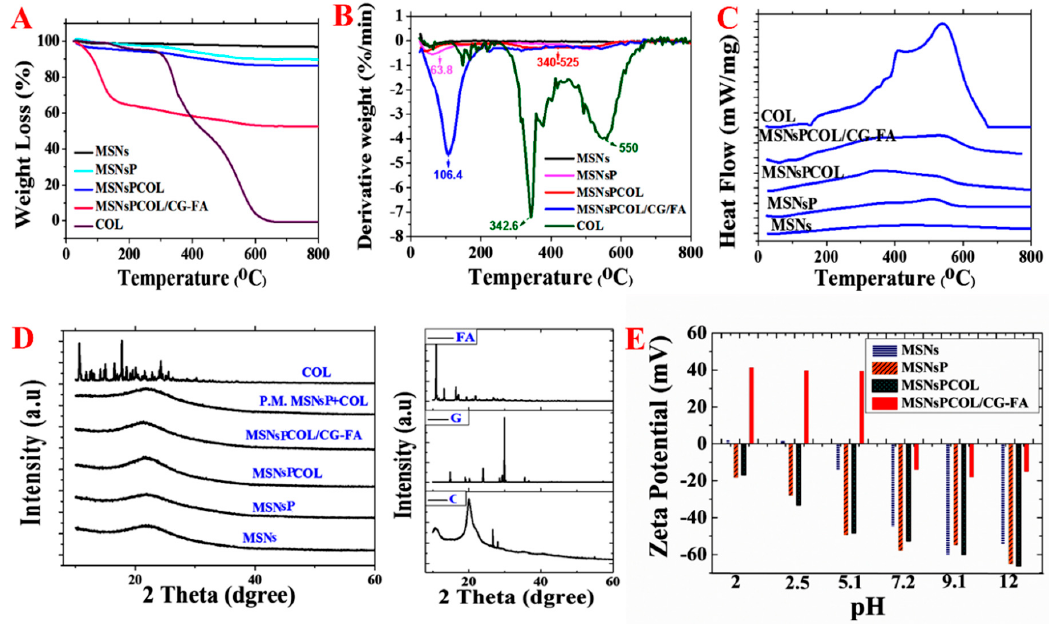
Figure 4. Thermal analysis of materials. ( A ) Simultaneous thermal analysis (STA) before and after surface modification, COL loading, and coating. ( B ) DTG analysis before and after surface modification, COL loading, and coating. ( C ) Differential scanning calorimetry (DSC) analysis before and after surface modification, COL loading, and coating. ( D ) X-ray diffraction (XRD) analysis before and after surface modification, COL loading, and coating. ( E ) Zeta potential measurements in aqueous solution before and after surface modification, COL loading, and coating.